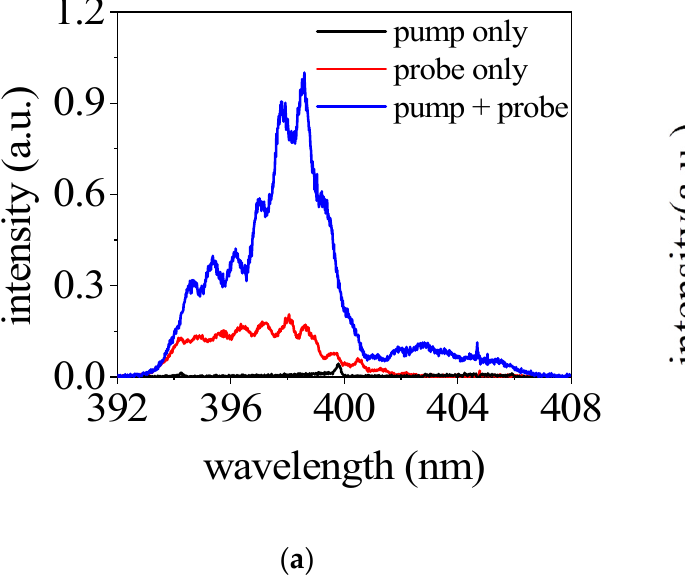
Figure 3. ( a ) SH spectra generated in the cases with pump and without pump pulse. ( b ) The signal intensities of SH at around 398 nm as a function of the time delay between pump and probe pulses with different nitrogen pressure.